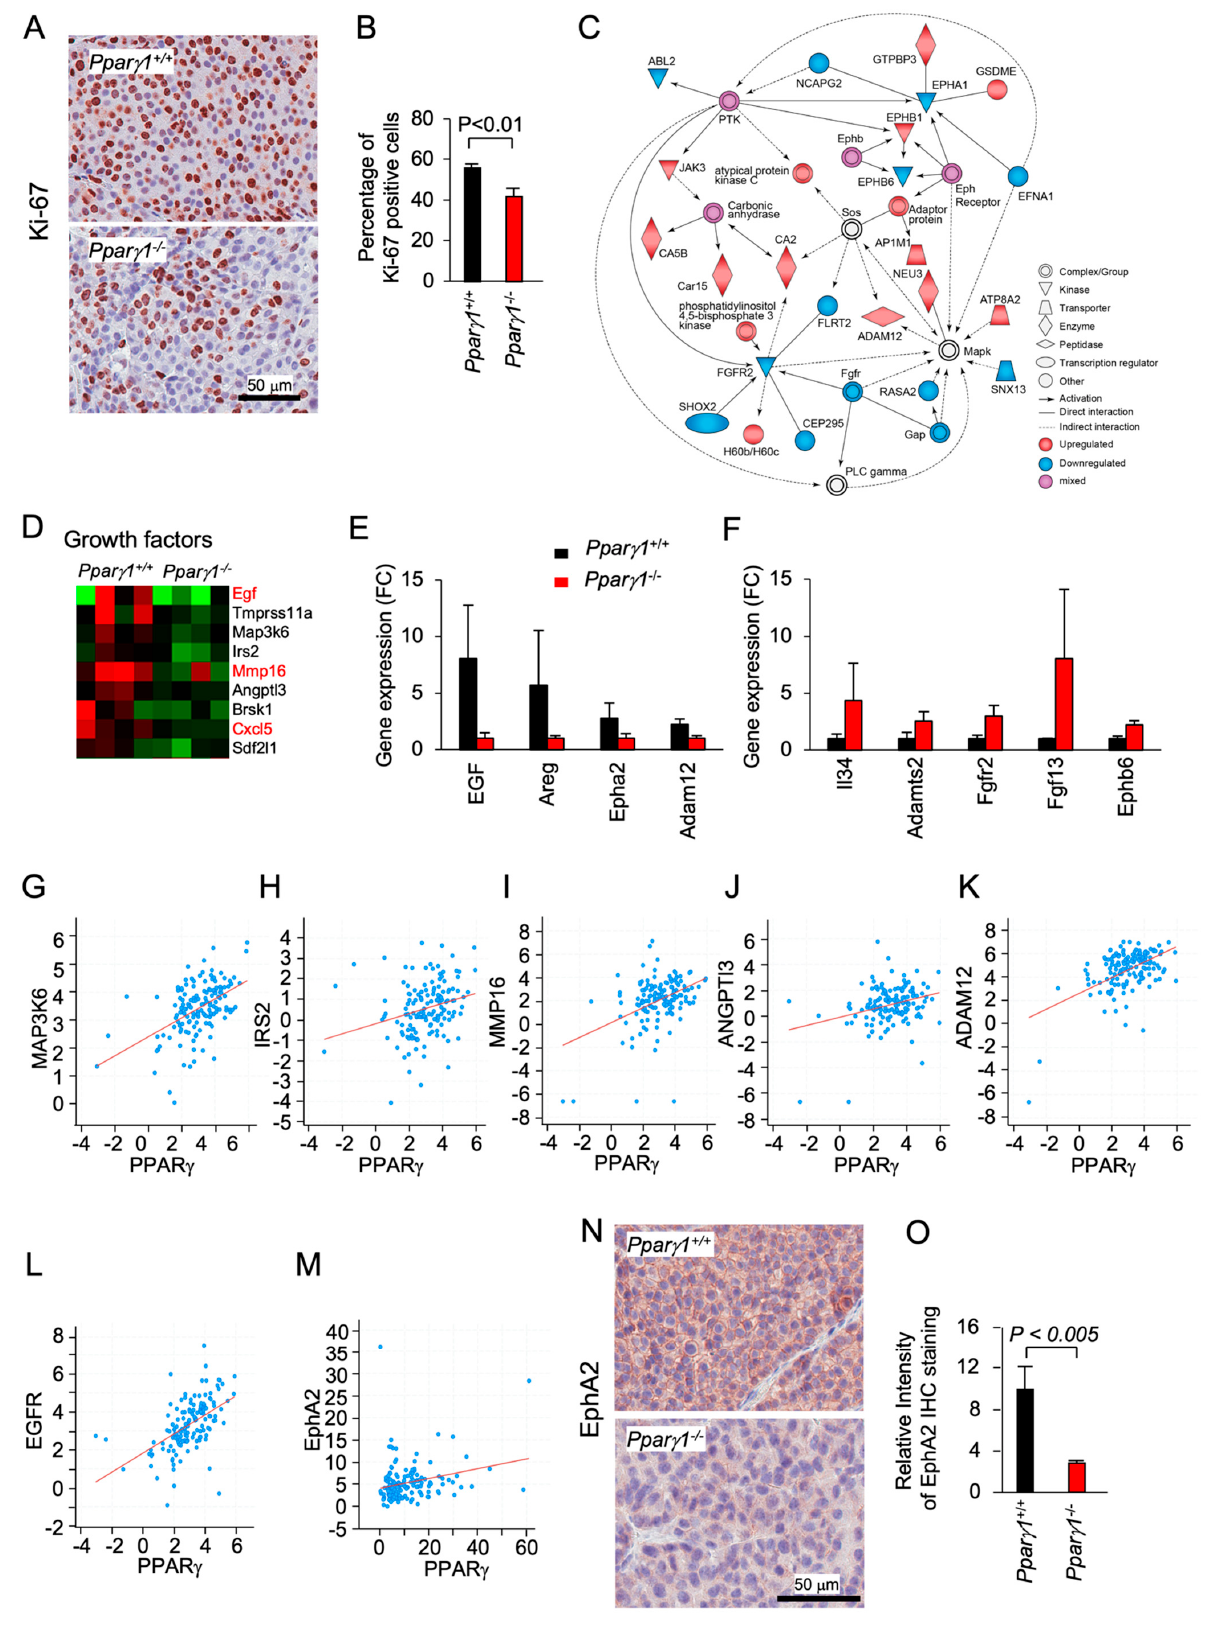
Figure 2. Ppar γ induction of EphA2-Areg growth factor signaling in ErbB2-induced mammary adenocarcinoma. The ErbB2 adenocarcinoma were analyzed for ( A ). Ki-67 by immunohistochemical staining with ( B ) quantitation as mean + SEM